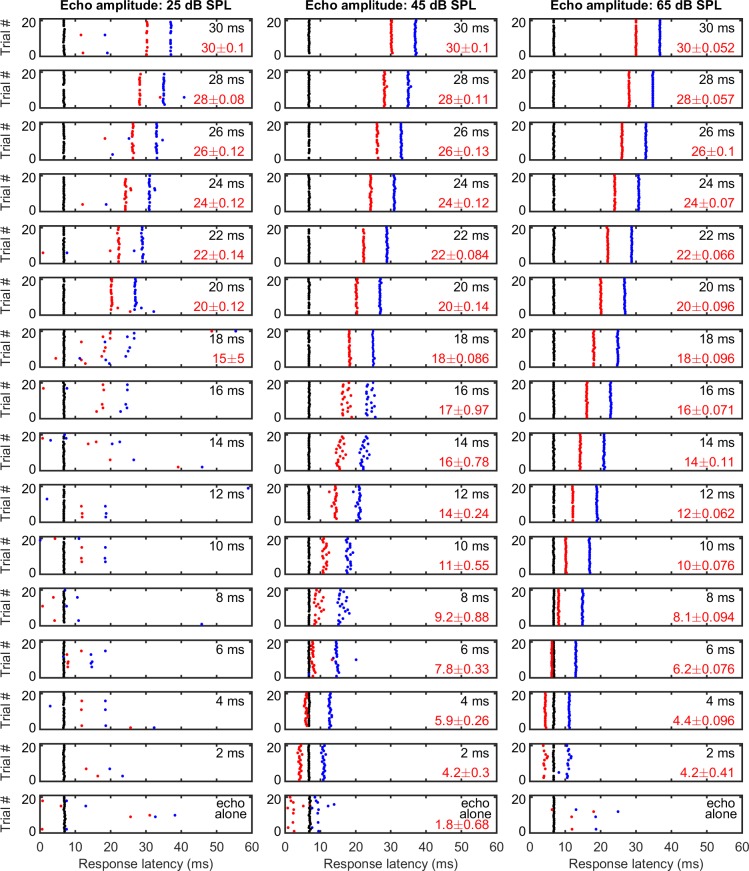
An example of time difference estimation for simulated call–echo pairs by EFP (200–600 Hz) over three echo amplitudes and a set of echo delays.The estimated time difference (red dots) increases with increasing echo delays and matches closely with the simulated echo delay at longer echo delays. For shorter echo delays, the estimated time differences were often larger. The “call” was 3 ms in duration and was presented at an amplitude of 75-dB SPL. The number in black at the top right corner of each panel indicates the actual echo delay of the simulated call–echo pair. The number in red (mean ± SD, only calculated for a sample size ≥10) shows the estimated time difference (red dots) by taking the difference between the second EFP latency (blue dots) and the first EFP latency (black dots). Each call–echo pair was presented 20 times. Data for this figure are included in S1 Data. EFP, extracellular field potential; SPL, sound pressure level.